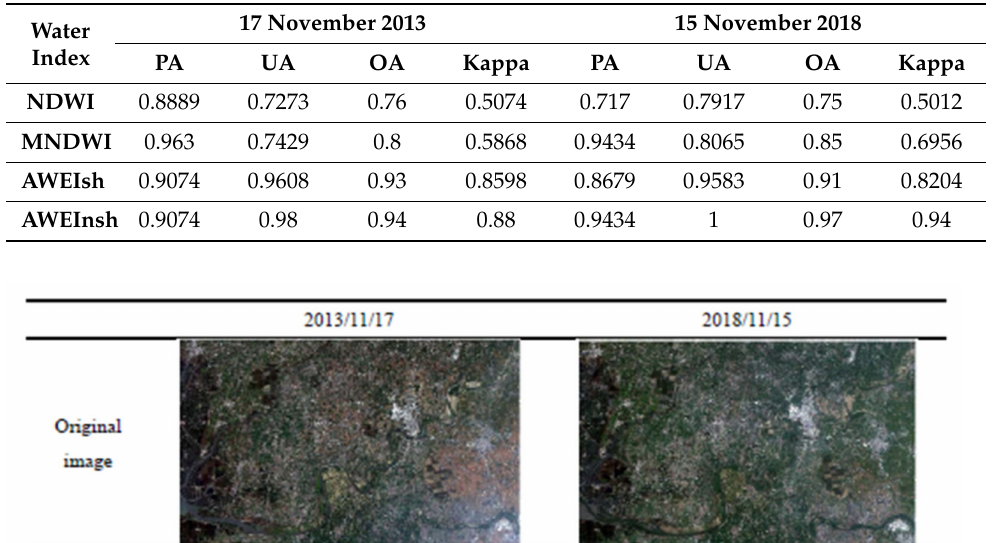
Table 7. Beigang River: Accuracy of spectral water body indices in terms of water body extraction on different dates.